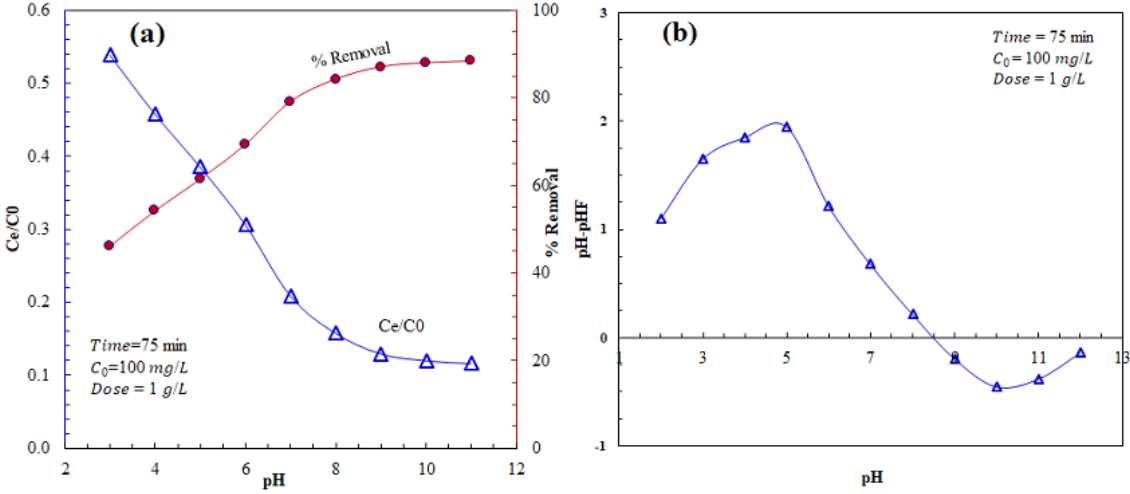
Figure 4. ( a ) Effect of pH on AZM adsorption by AFAC and ( b ) the pH pzc of